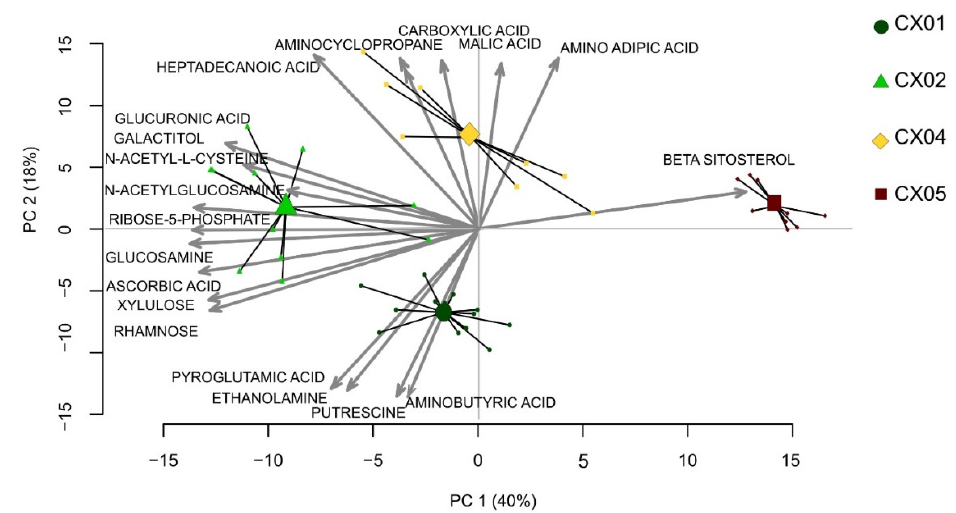
Figure 3. Metabolite profiles of various Aloe extracts. Principal component analysis (PCA) biplot derived from metabolites identified from various Aloe extracts, including CX01 (5 batches, dark green dots), CX02 (4 batches, light green triangles), CX04 (3 batches, yellow diamonds) and CX05 (3 batches, maroon squares). The individual samples of each extract based on 210 metabolites are connected to a centroid, indicating the weighted mean of the group. The PCA biplot also depicts the loading of the most relevant metabolites involved in the separation of the extracts.